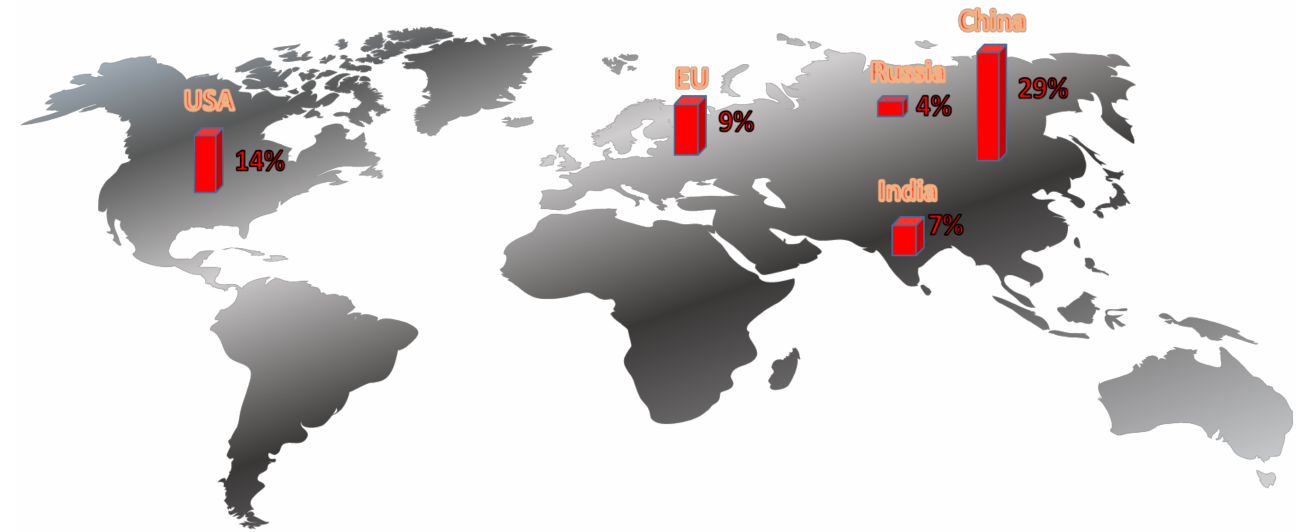
Figure 1. World carbon dioxide emissions from fossil fuel combustion percentages (based on JRC2019 reports